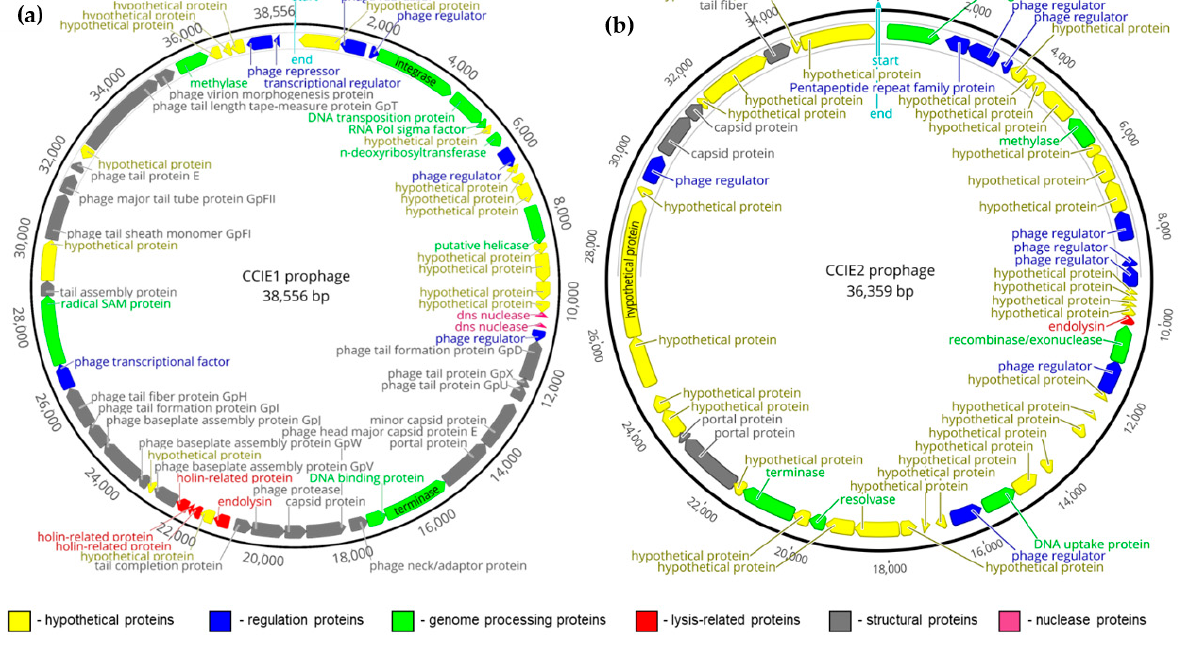
Figure 1. Genome annotation of the newly identified CCIE1 ( a ) and CCIE2 ( b ) prophages. The genome of both CCIE1 and CCIE2 prophages and their annotated CDS are represented. Hypothetical proteins for which no annotation update was possible are represented in yellow. Regulation proteins and genome processing proteins are depicted, respectively, in blue and green, while lysis-related proteins and structural proteins are highlighted in red and grey, respectively. Partial dns nuclease found in CCIE1 is shown in lilac. For space simplification, the linear prophage region is represented as a circular genome, with start (first residue) and end (last residue) highlighted at 0 ′ position of each representation. The figure was obtained using Geneious Prime 2020.1.1. Further description of the annotated regions is available on Table S3.